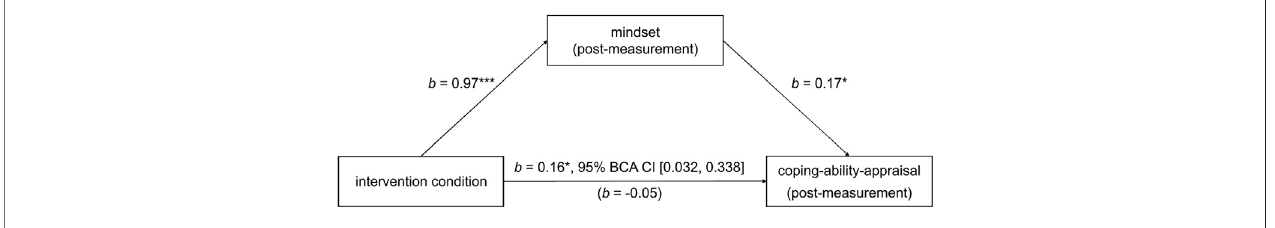
FIGURE 2 | Mediation model for the relationship between the intervention and coping-ability appraisal at postmeasurement mediated by mindset at postmeasurement indicated by standard regression coef fi cients. The standardized regression coef fi cient between the intervention and coping-ability appraisal, controlling for mindset, is in parentheses (direct effect). BCA CI, bootstrapped CI. * p < 0.05, ** p < 0.01, and *** p < 0.001. N (cid:1) 77.